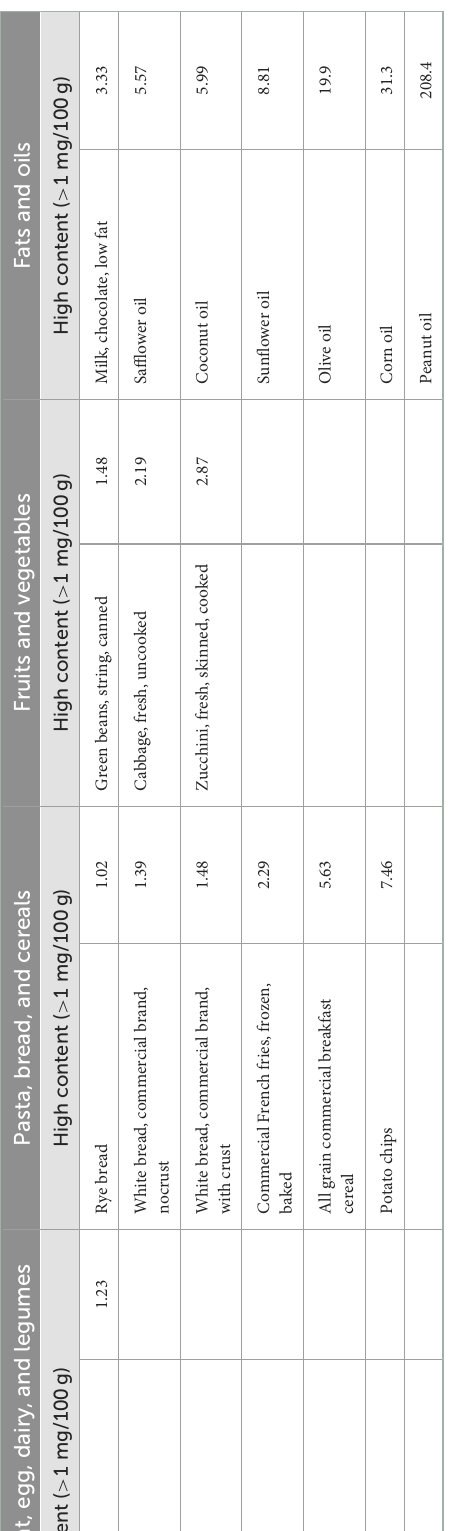
TABLE 3 Laboratory tests for nutritional assessment.